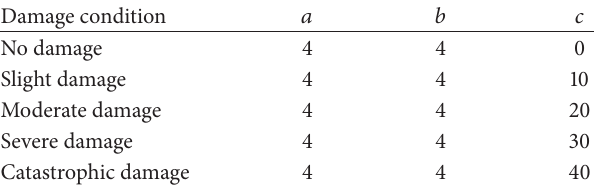
Figure 8: Modal curvature difference for damage localization with multiple locations.